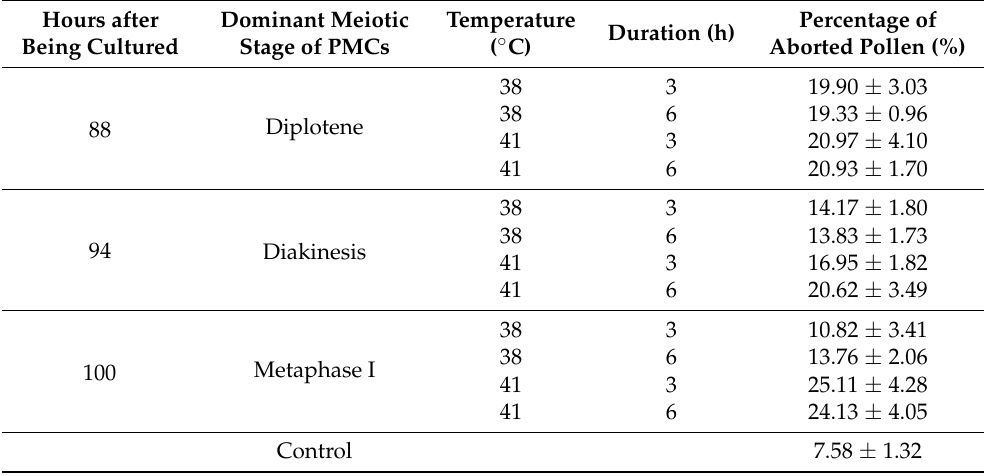
Pollen morphology was studied by scanning electron microscopy. The pollen grains within the control group was uniform and spherical, with few corrugations and a granular surface (Figure 2a,b,c). There were no apertures on the surface. Few aborted pollen grains (arrows) were induced (Figure 2b,c) by 38 °C high temperature for 3 h or 6 h. The morphology (Figure 2d,e) and the ectexine structure (Figure 2f,g,h,i) of induced pollen were similar to the control group, suggesting that high temperature had no significant effects on the pollen morphology.